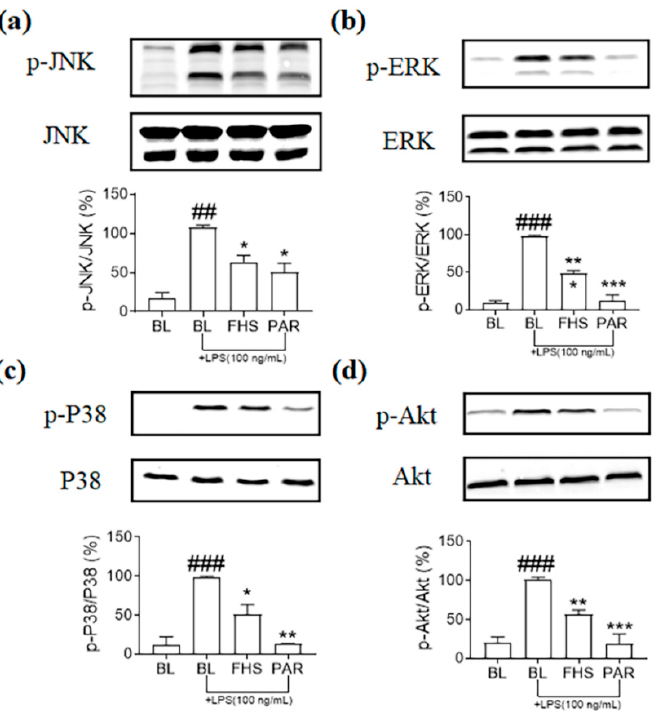
Figure 5. FHS suppressed the phosphorylation of key proteins in MAPKs ( a – c ) and PI3K/Akt ( d ) signaling pathways. Cells were incubated with FHS for 1 h and then incubated with LPS for another 15 min. p-ERK ( a ), p-JNK ( b ), p-P38 ( c ), and p-Akt ( d ) were examined by western blot and standardized with the total ERK, JNK, P38, and Akt, respectively ( n = 3). BL, medium without the addition of extracts; FHS, fermented hemp seed-containing medium’s supernatant of Day 7. ## p < 0.01, ### p < 0.001 vs the control group; * p < 0.05, ** p < 0.01, *** p < 0.001 vs the LPS-treated group.